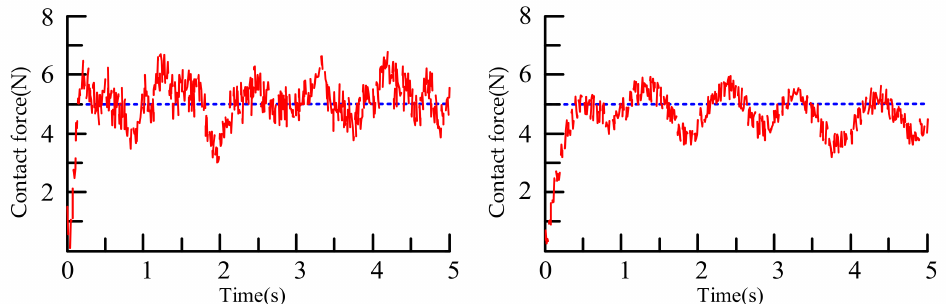
Figure 16. The left shows the results of conventional impedance control experiments; the right shows the results of adaptive impedance control